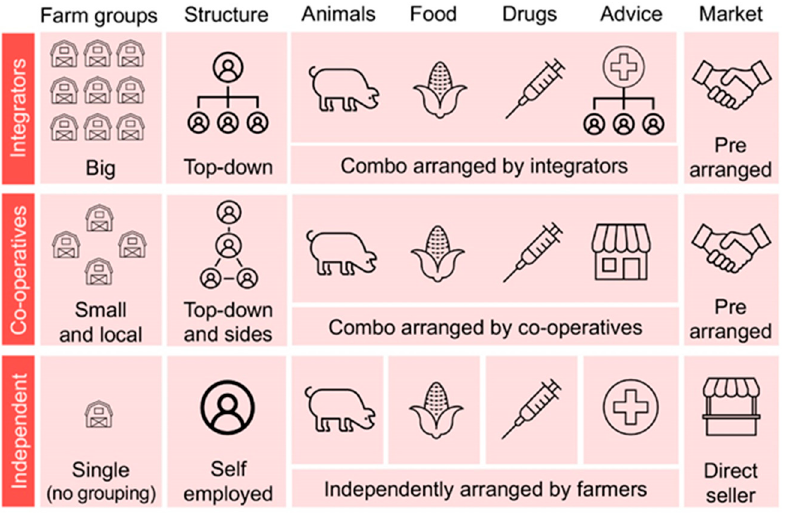
Figure 1. Schematic representation of pig production models in Brazil. Most of the independent farmers (67%) produced their animal feed on their farms from grains they produced themselves and some additional external inputs (e.g., vitamin and mineral ingredients) purchased from local shops or through vendors. When they con- sidered it necessary to add antibiotics to the feed for group treatment or for prophylactic use, independent farmers bought the powdered antibiotics for mixing in feed. It is impor- tant to note that these farmers were not complying with the norms of IN65/2012/MAPA (F30a). However, their reports indicated that they were not sufficiently informed about these regulations and that they did not consider this practice incorrect. The supply